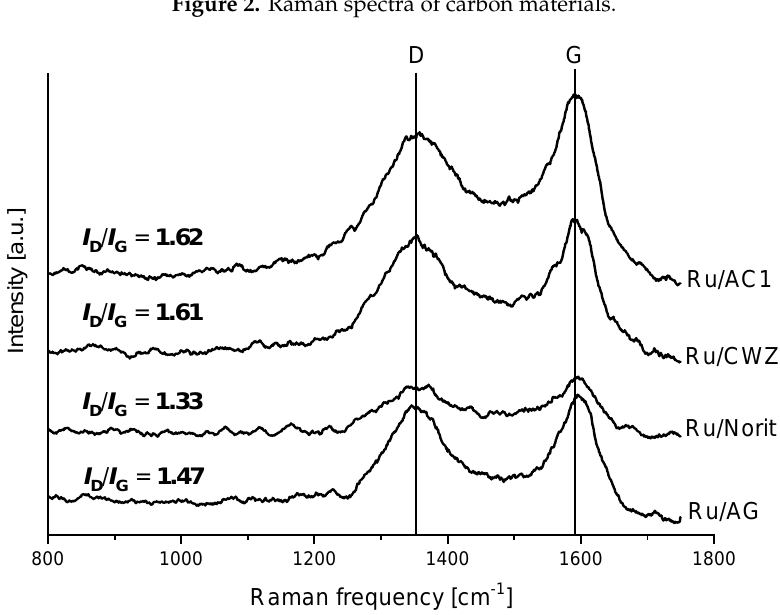
Figure 2. Raman spectra of carbon materials.